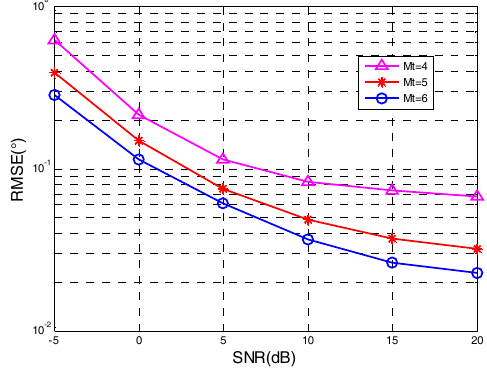
Figure 6. Angle tracking with different values of Mt .